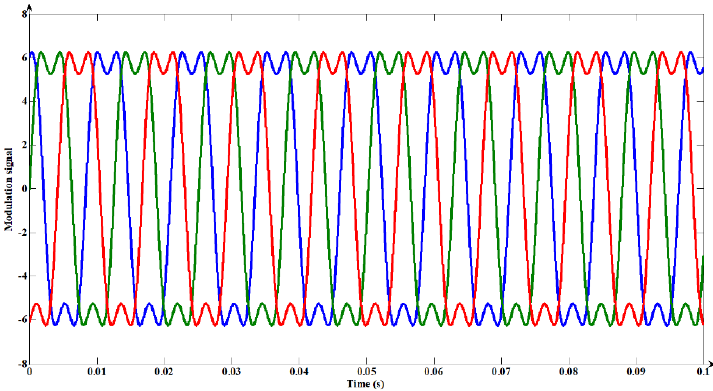
Figure 42. Depenbrock’s PWM-3 phase waveform.